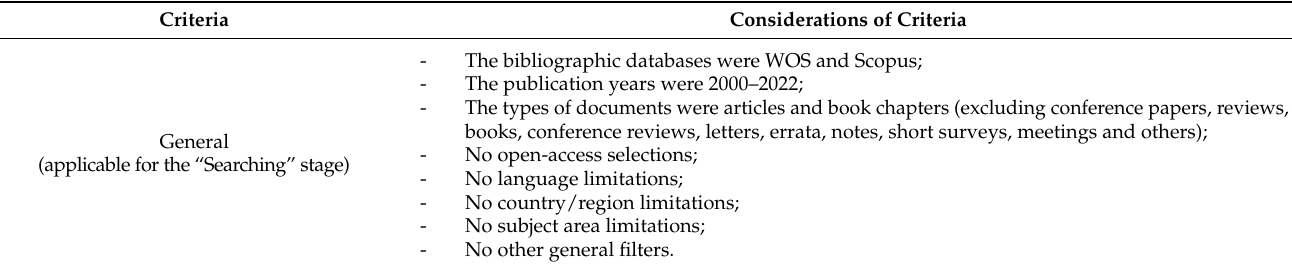
Table 1. Eligibility criteria defined for the